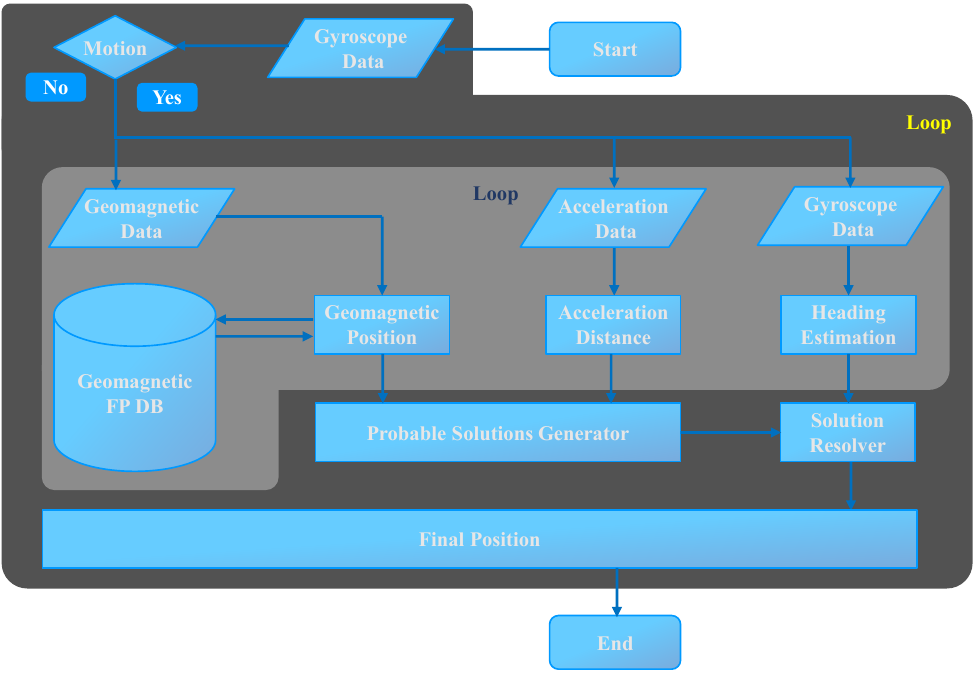
Figure 9. Geomagnetic positioning algorithm process.